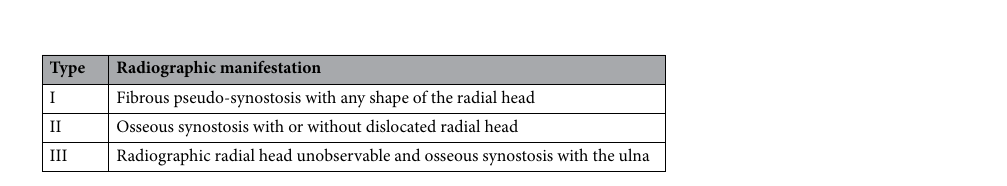
Table 4. MRI & X-ray based congenital PRUS